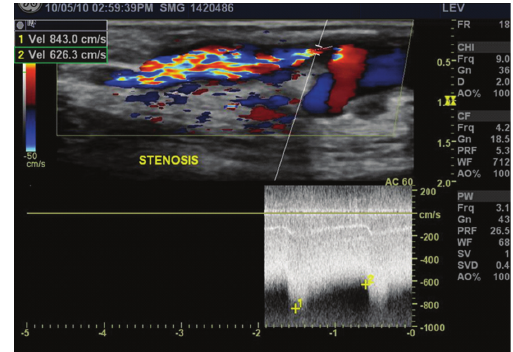
Figure 2: A high-grade stenosis is noted just distal to the take- o ff of a branch, where a marked elevation in both peak systolic (843.0cm/sec) and end diastolic (626.3 cm/sec) velocities is found. Doppler color flow imaging demonstrates post-stenotic turbulence distal to the narrowest segment of the